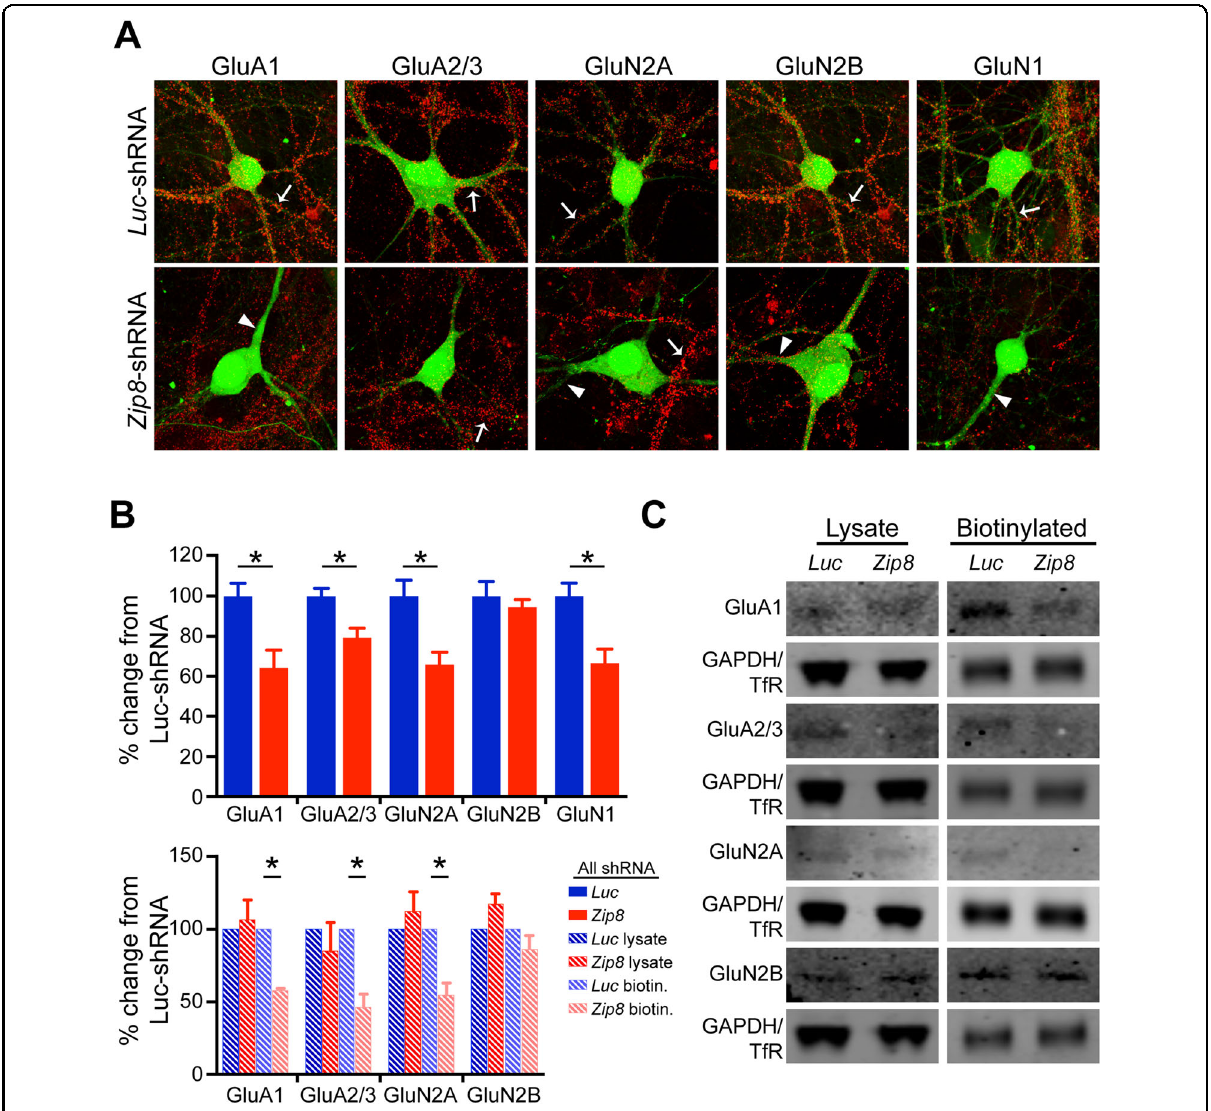
Fig. 3 ZIP8 KO in cultured neurons leads to decreased surface localization of speci fi c glutamate receptor subunits. A Representative neurons expressing GFP-tagged Luc- or Zip8 -shRNA and stained with antibodies against different glutamate receptor subunits at DIV28 – 30. Arrows denote neurites from Luc -shRNA-expressing neurons (top) or surrounding non-transfected neurons in the Zip8 -shRNA condition (bottom). Arrow heads indicate neurites from Zip8 -shRNA-expressing neurons. B Quanti fi cation of different glutamate receptor subunits ’ staining intensity relative to Luc - shRNA treatment. Intensity of signal for each subunit from the Luc -shRNA treatment was averaged and used to normalize Luc - and Zip8 -shRNA treatments. * P < 0.05 (Student ’ s t -test); n = 6 – 10 per group. Error bar, SEM. C Representative western blot of individual glutamate receptor subunits, as quanti fi ed in B